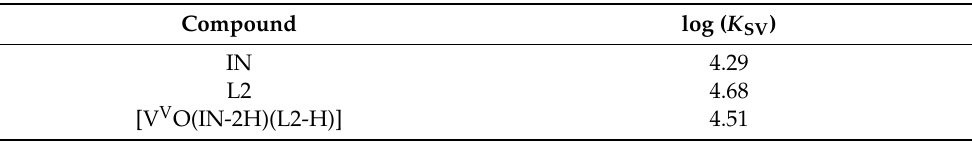
Table 3. Stern–Volmer constants for [V V O(IN-2H)(L2-H)], L2 and IN for the competitive binding to {DNA-EB}